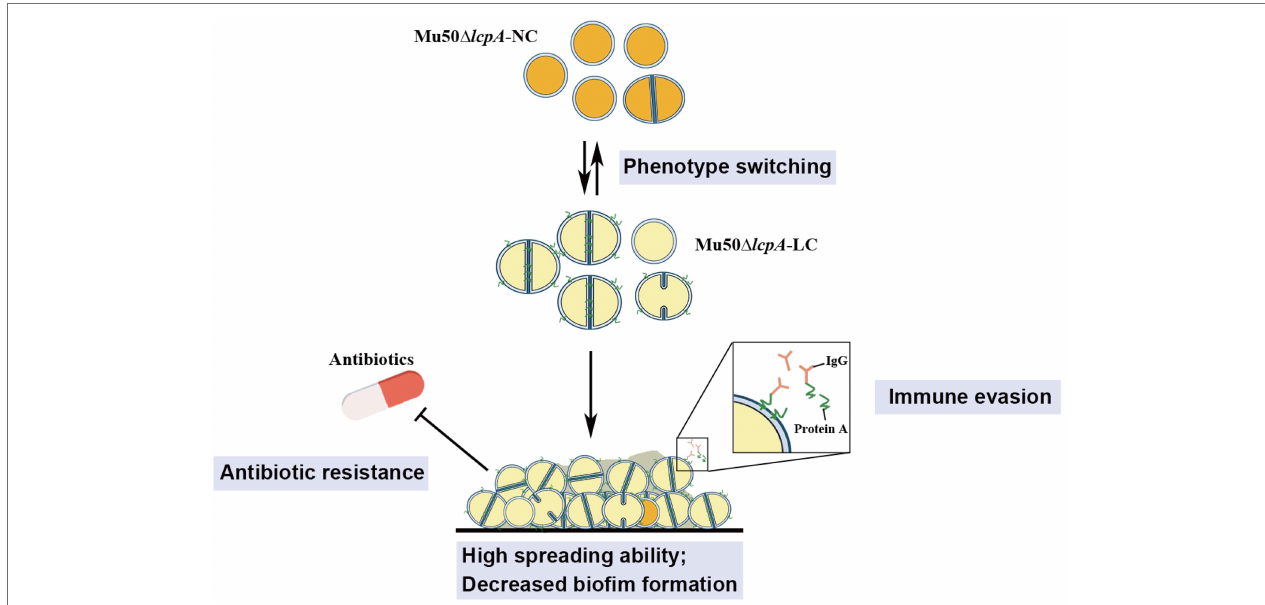
FIGURE 5 | Illustration of the phenotype heterogeneity in an isogenic population of S. aureus . The population of MRSA Mu50 ∆ lcpA consists of two subpopulations that produce large colony morphology (Mu50 ∆ lcpA -LC) and normal colony morphology (Mu50 ∆ lcpA -NC) on agar plates. These two morphologies occur reversibly. Most Mu50 ∆ lcpA -LC cells possess a complete septum and have a large cell size. Importantly, this less pigmented Mu50 ∆ lcpA -LC exhibited a high spreading ability on solid media and had increased resistance to β -lactam antibiotics. Moreover, upregulated spa expression suggests enhanced ability of Mu50 ∆ lcpA -LC to evade immune responses. This phenotypic switching will help S. aureus to survive complex host